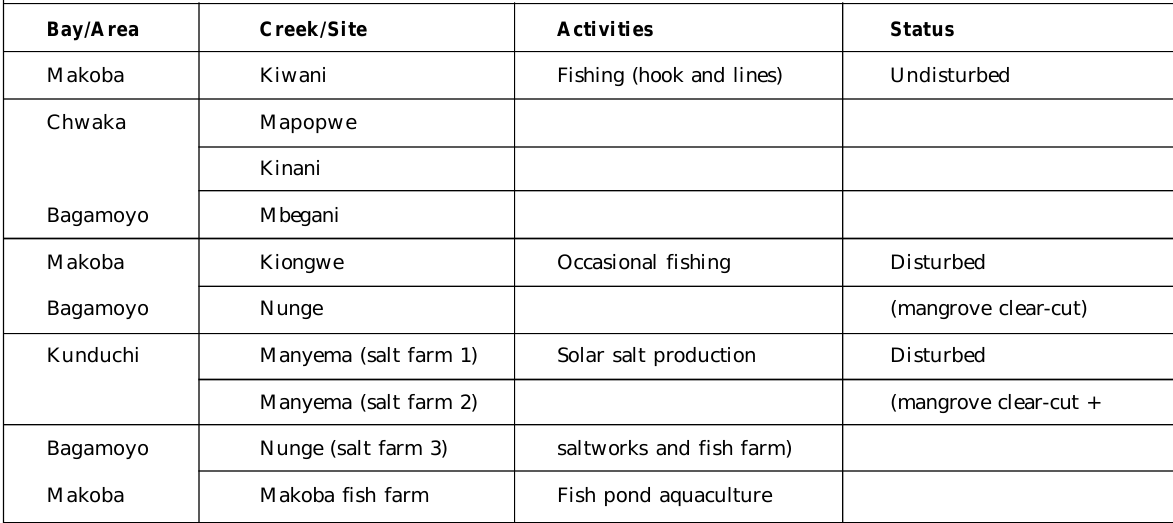
Table 1: Human-based disturbances on mangrove creeks studied along Tanzanian coastline